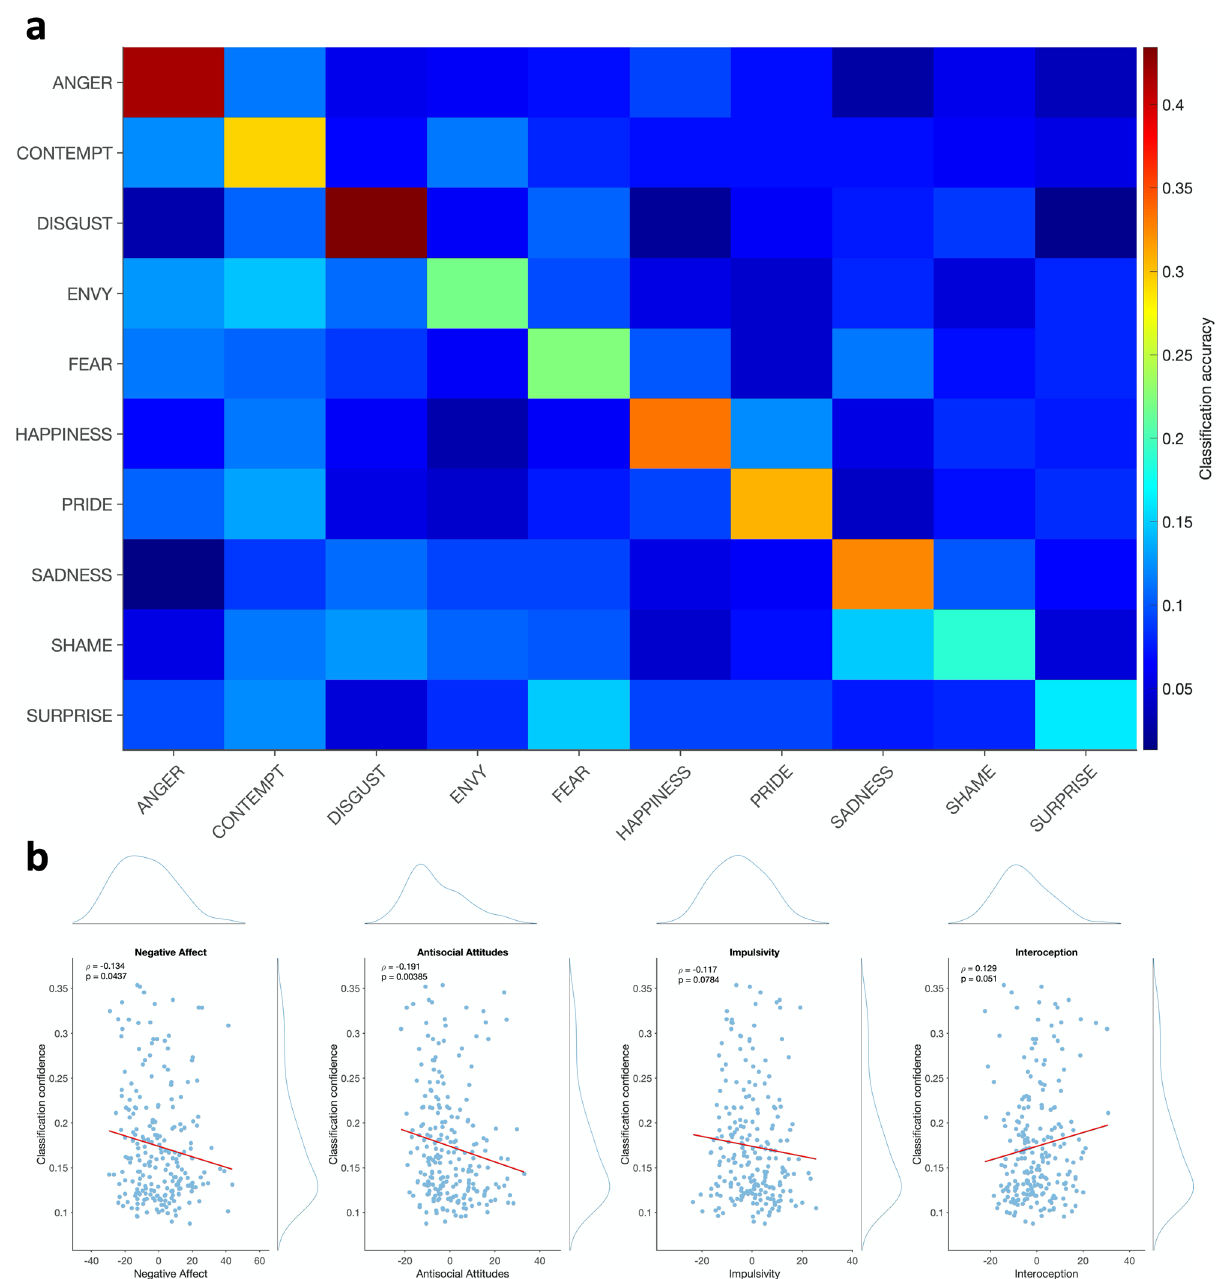
Figure 3. Linear discriminant analysis classifier confidence and its association with personality. ( a ) Confusion matrix for the linear discriminant analysis classifier predicting emotion label from participants’ BSM data. ( b ) Correlations of classifier confidence with personality PCA components. Classifier confidence was computed as the posterior probability that an emotion is accurately classified as its true label, averaged over emotions for each subject. Spearman’s ρ and uncorrected p values are indicated. Histograms show the distribution of each